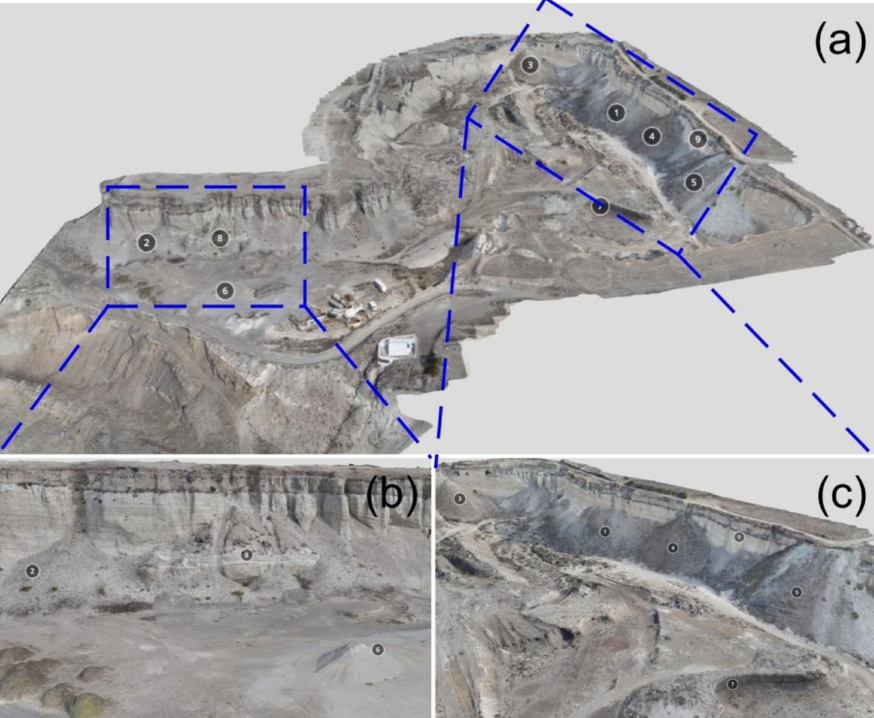
Figure 12. ( a ) A view of the Metaxa Mine (view to the north), ( b ) detail of the area where the Minoan products crop out, representing all the phases of the Minoan eruption, ( c ) detail of the area where debris flows deposits and anthropogenic interventions mostly